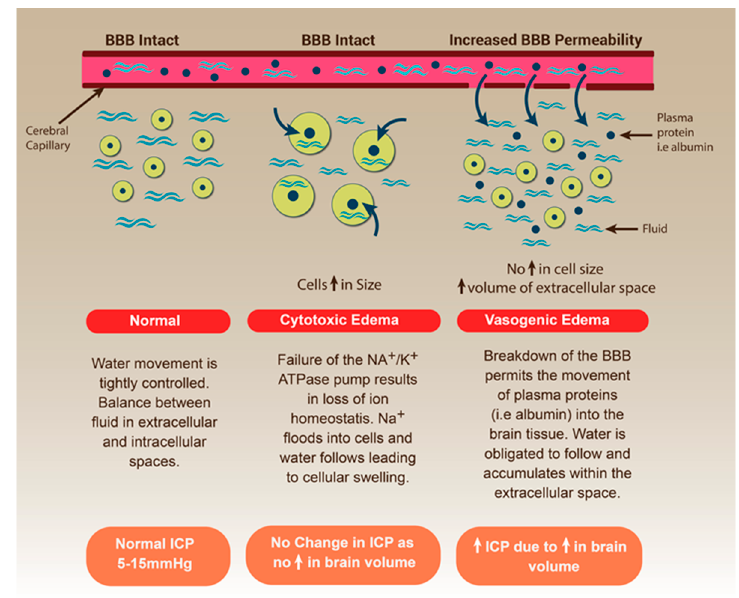
Figure 1. Development of cerebral oedema in acute central nervous system (CNS) injury. Note the relative size of the cells within the brain tissue and surrounding volume of the extracellular space under normal conditions and how this differs in both cytotoxic oedema and vasogenic oedema. Arrows indicate compartmental movement of water.